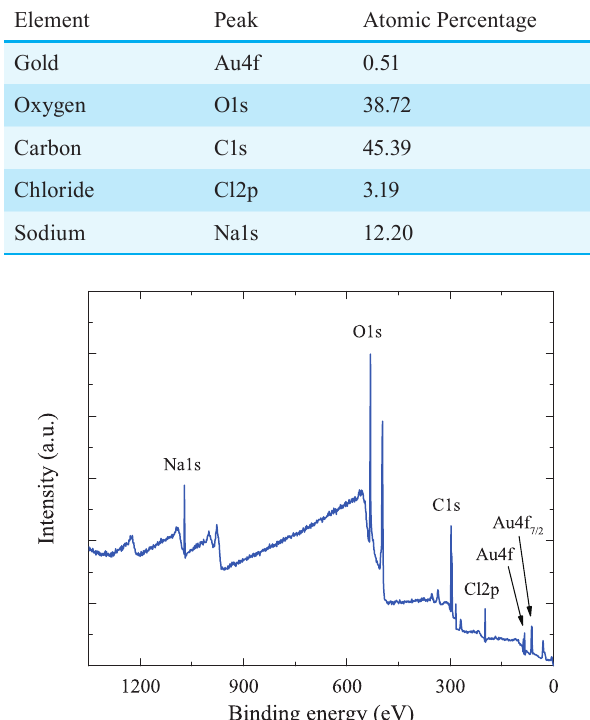
Table 2 XPS data of the 15 nm AuNP